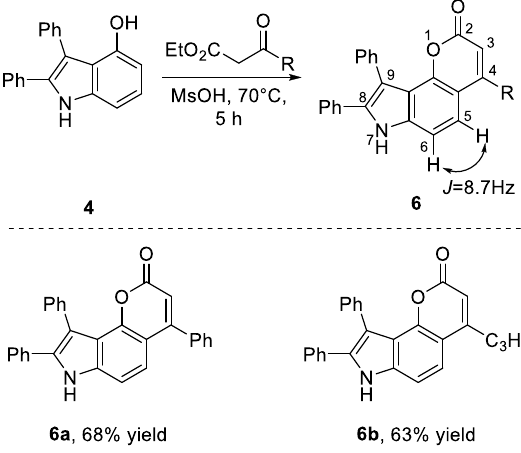
Figure 2. X-ray crystal structure of pyrano[2,3- e ]indole 6b (CCDC 2152277 ). 4-Propylpyranoindole 6b was characterized by a quantum yield of luminescence of 7%, while its phenyl counterpart 6a did not exhibit luminescent properties at all (see Sec- tion 2.2). Thus, indoles 6 have weak fluorescent properties, and this direction was also abandoned.